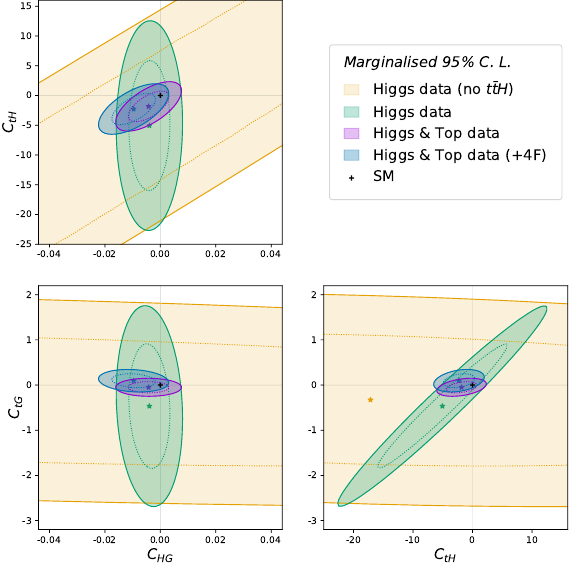
Figure 10 . Same as figure 7, but setting C G = 0